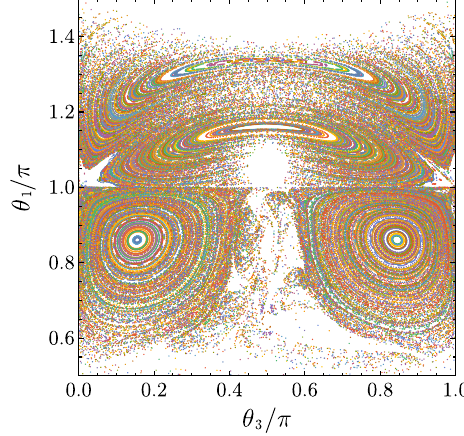
_ θ 0 Þ for the de- 2 <